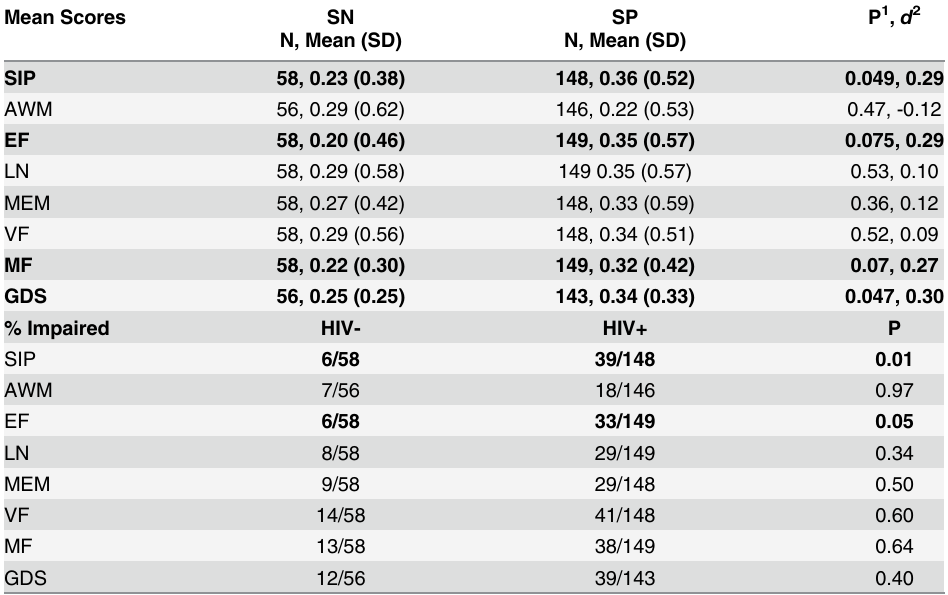
Table 3. Comparison of ability deficit domain scores and frequency of impairment for all study participants. Mean Scores SN SP P 1 , d